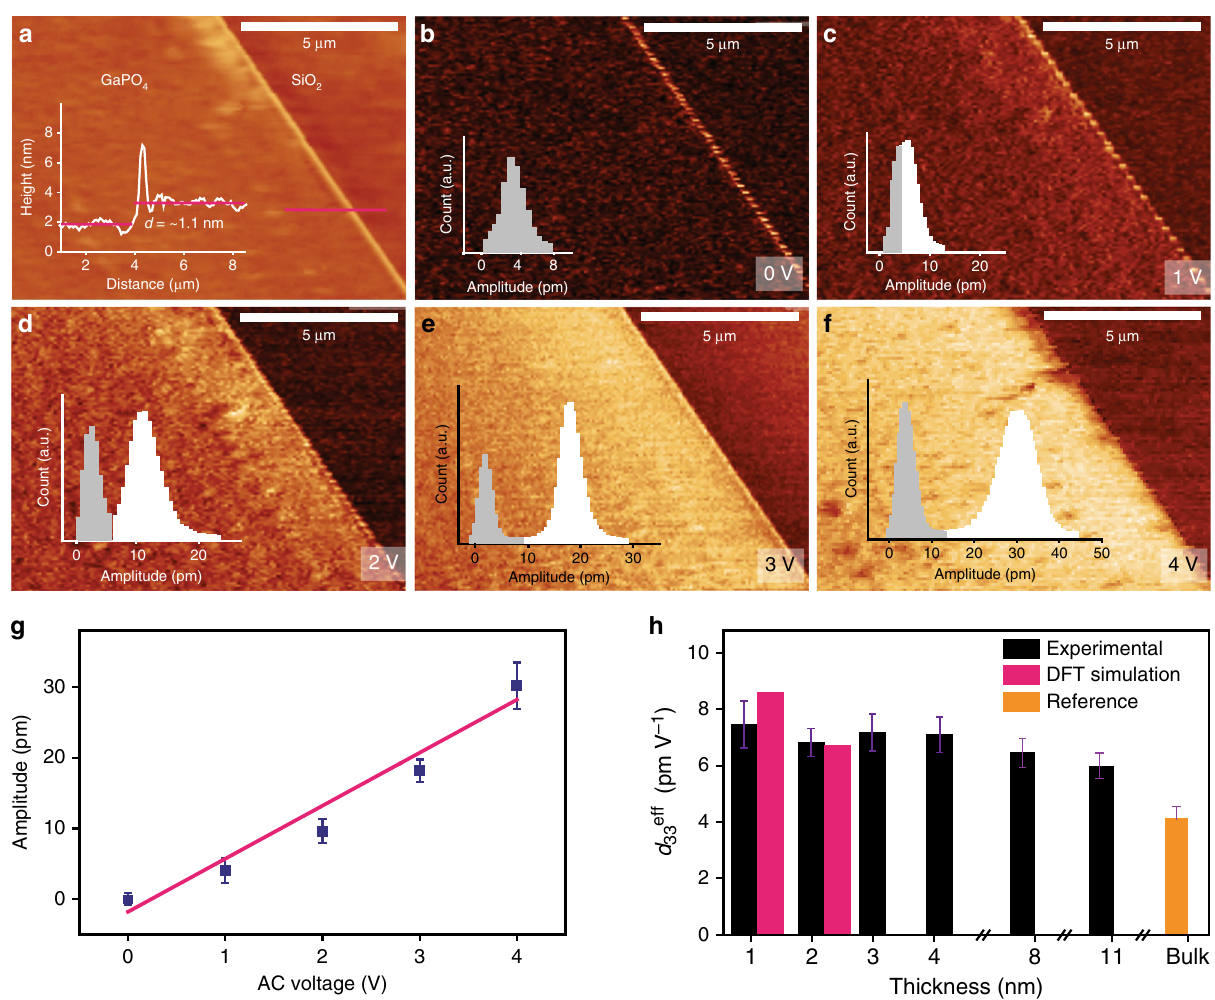
Fig. 4 Characterisations of out of plane piezoelectricity of 2D GaPO 4 . a AFM topography of a unit cell thick GaPO 4 nanosheet. b – f Vertical piezoresponse amplitude pro fi les at different AC driving voltages. The insets represent the statistical distribution of the piezoresponse amplitude variations of GaPO 4 fi lm (white colour) and the substrate (grey colour). g Average piezoresponse amplitude as a function of the applied AC voltage extracted from the statistical distributions of the amplitude variations of GaPO 4 and the substrate. Error bars signify the standard deviations which are introduced to indicate uncertainty of the measurements. h Value of d eff 33 for GaPO 4 fi lms with different thicknesses. The bulk value for d 33 is extracted from ref. 49 . Error bars signify the deviations of slope of piezoelectric amplitude for the driving bias voltage (AC) for experimental d eff 33 . DFT simulations of 2D GaPO 4 nanosheets of higher thicknesses are not reported due to dif fi culties with accuracy and energy